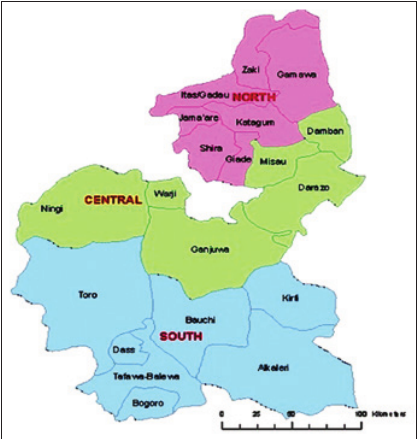
Figure-2: Map of Bauchi State showing the senatorial zones (study